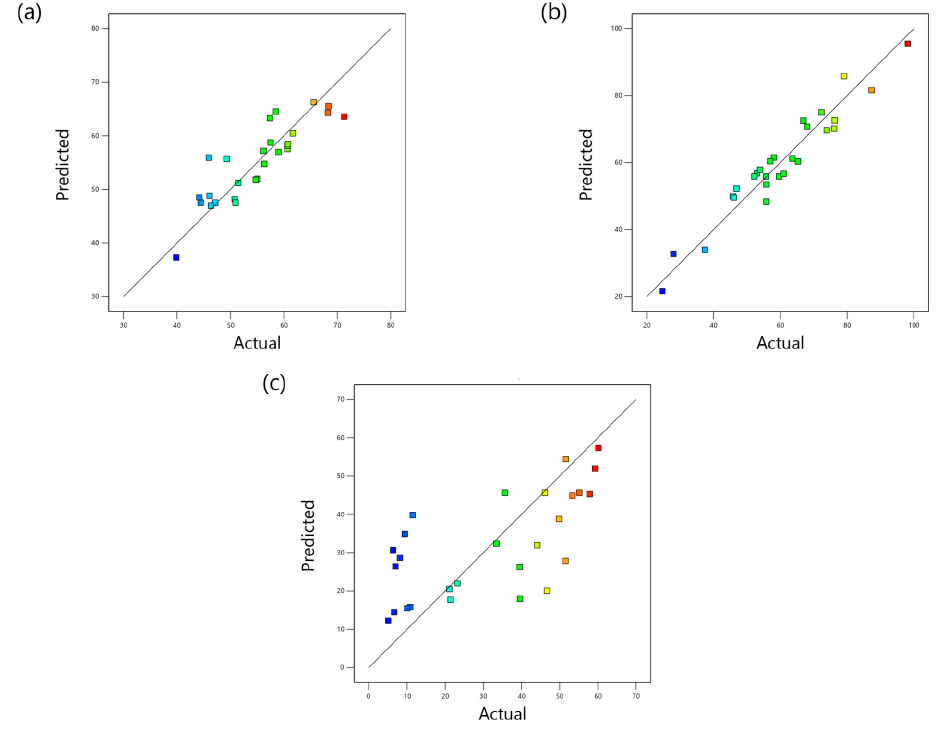
Figure 2. RSM predicted vs. actual values for ( a ) TC removal, ( b ) TOC removal, and ( c ) TN removal.